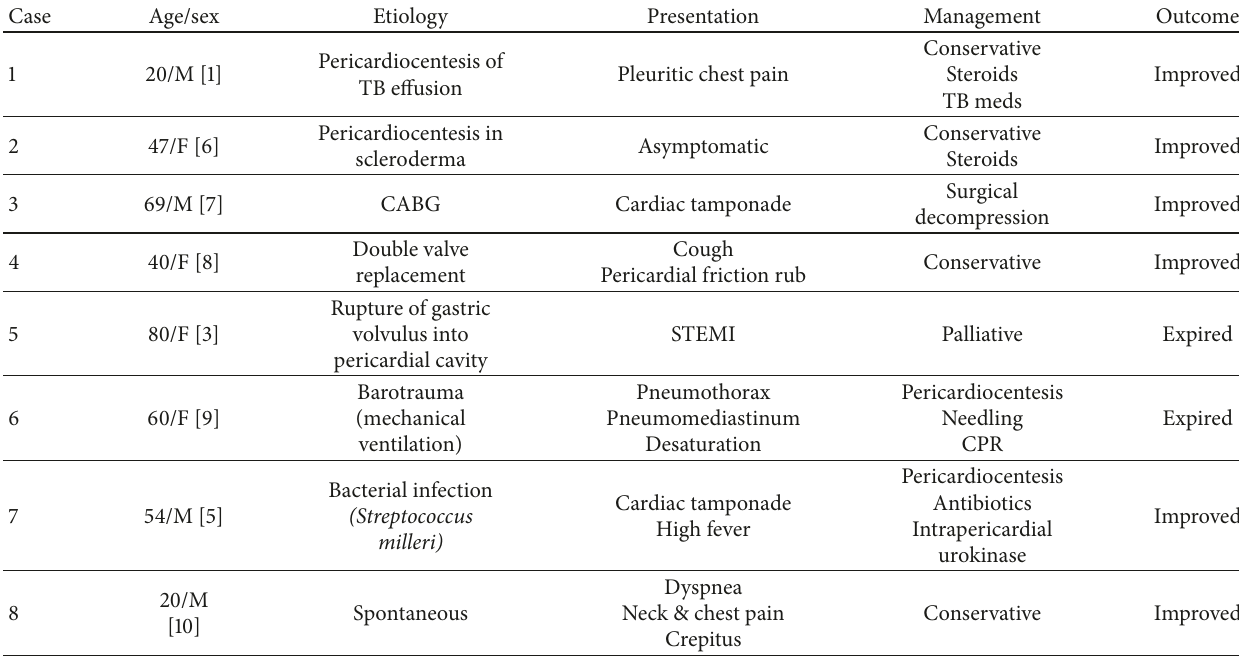
Figure 8: Intraoperative findings. (a) Pericardiectomy through median sternotomy was performed. (b) Stripped pericardium with measured thickness of 5–7mm. (c) Caseous material extracted from the pericardial sac. Table 1: Summary of selected case reports on